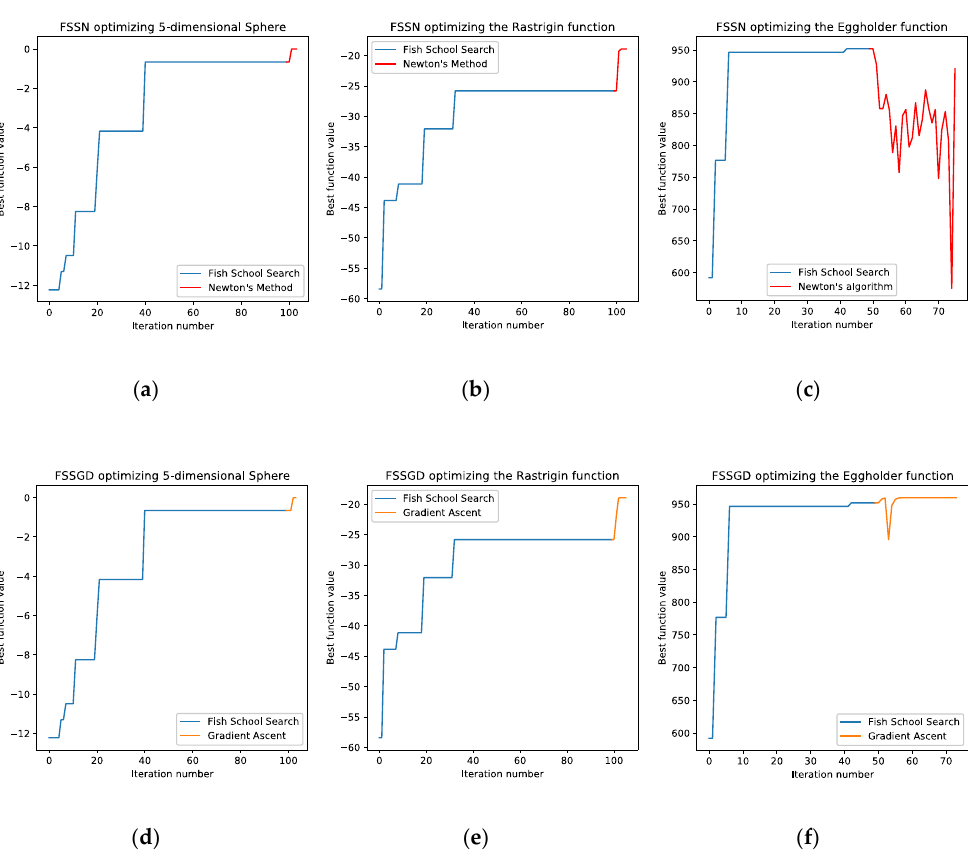
Figure 2. Hybrid algorithms optimizing test functions from Table 1.